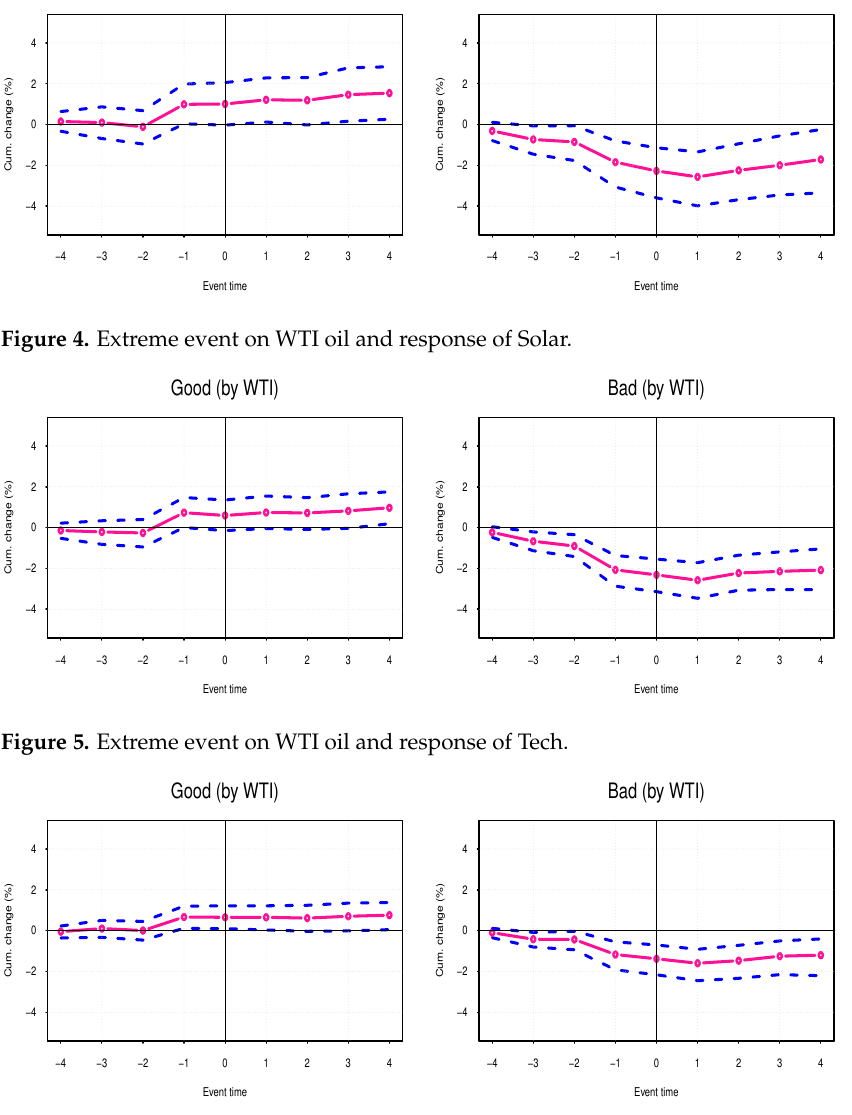
Figure 6. Extreme event on WTI oil and response of